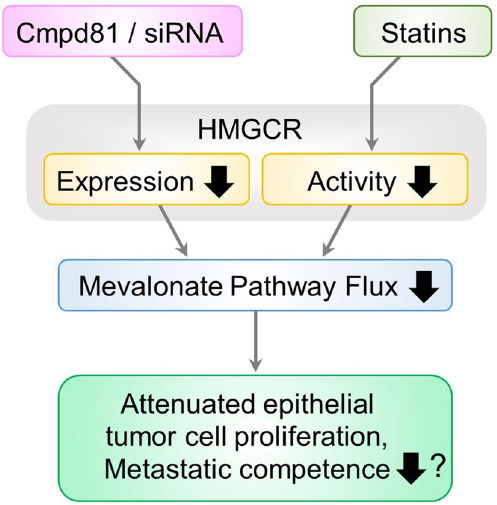
Figure 6. Dual inhibition of HMGCR in TGF-β-induced epithelial cancer cells. Following microenvironment- induced phenotypic state switch in epithelial cancer cells the dual inhibition of HMGCR, by downregulation of its expression (by siRNA or Cmpd81) and its enzymatic activity (by statins) leads to reduced cholesterol levels and reduced synthesis of the mevalonate pathway’s intermediate metabolites that are required for prenylation